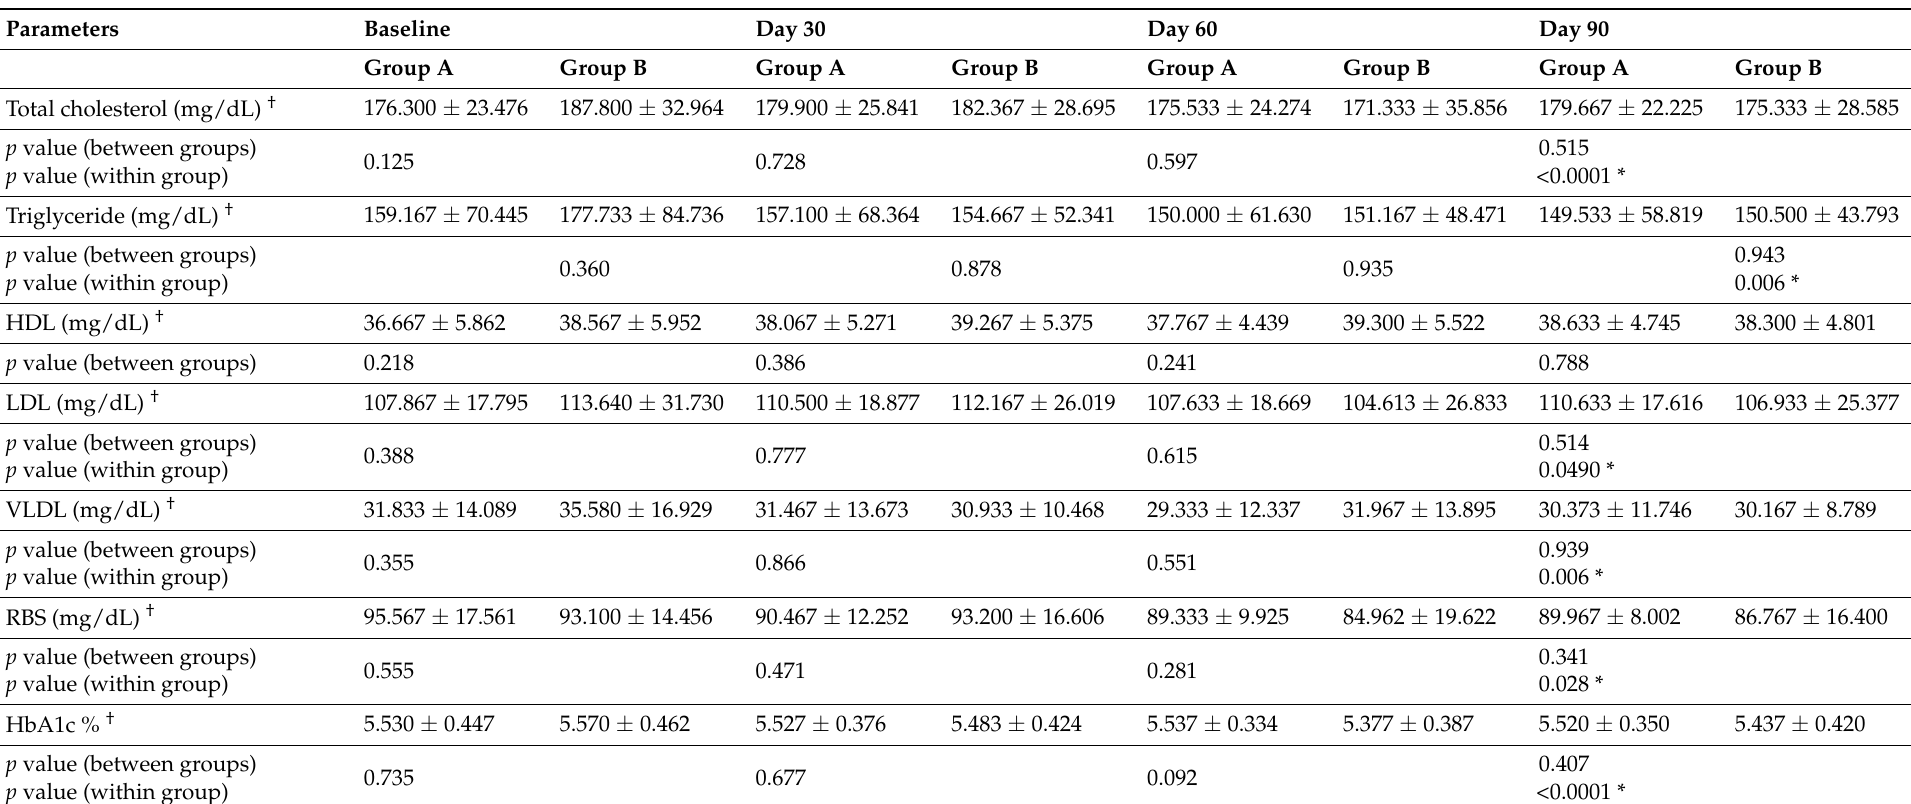
Table 4. Secondary